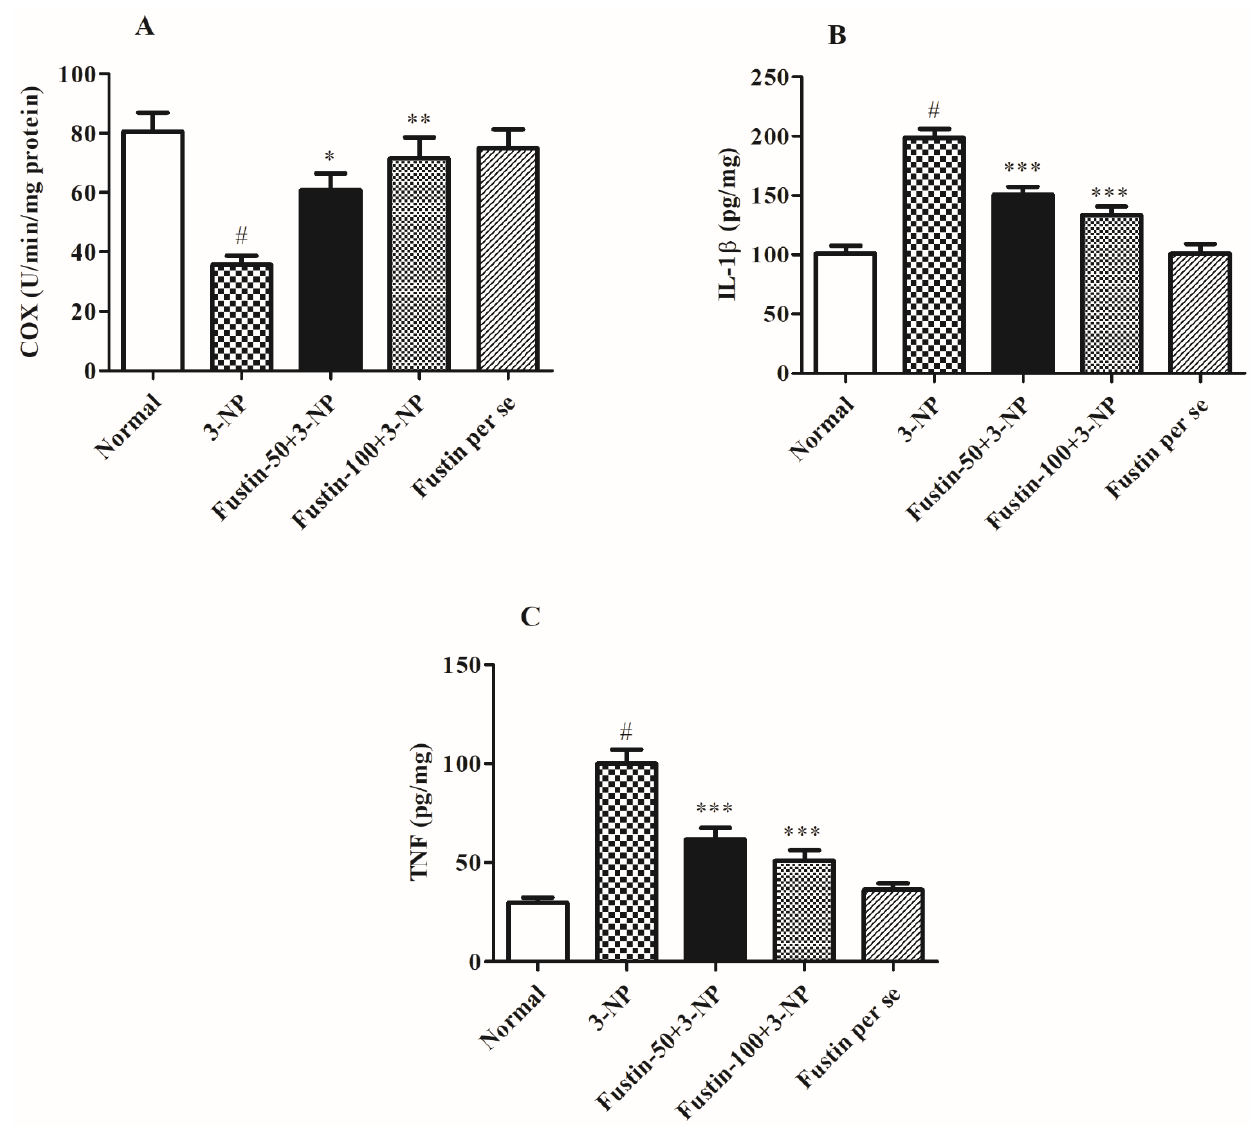
Figure 6. Effect of fustin on brain pro-inflammatory markers against 3-nitropropionic acid-induced Huntington’s-like effects in rats ( A ) COX, ( B ) IL-1 β , ( C ) TNF- α . Values are expressed as mean ± S.E.M. ( n = 6). Values are statistically significant at # p < 0.05 vs. negative control group, * p < 0.05 vs. 3-nitropropionic acid, ** p < 0.01 vs. 3-nitropropionic acid, *** p < 0.001 vs. 3-nitropropionic acid, respectively (One-way ANOVA followed by Tukey’s test).